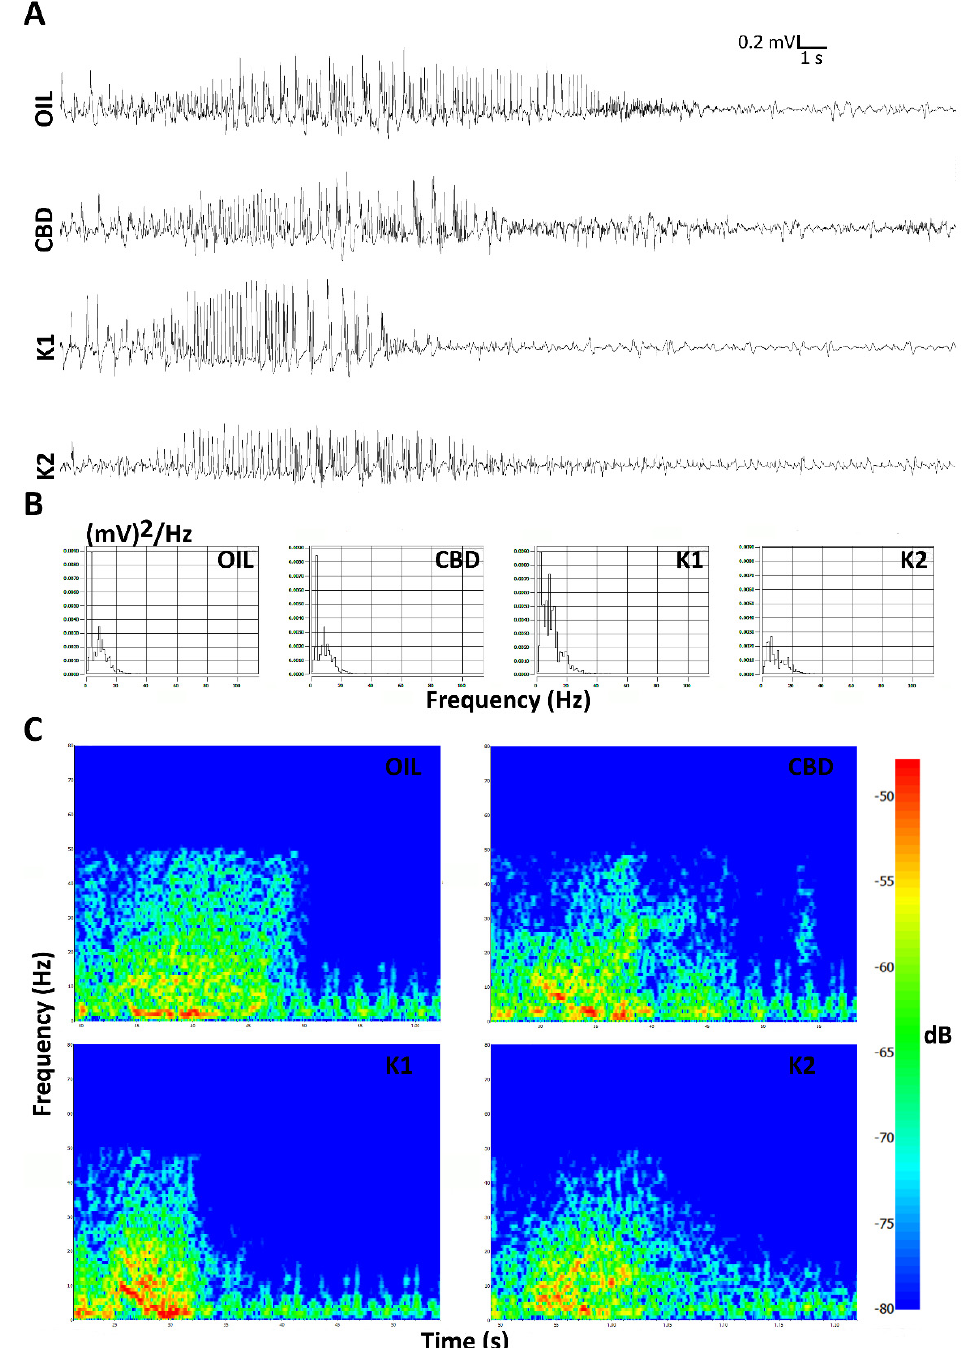
Figure 3. Seizures induced after the last session of 6-Hz corneal stimulation are illustrated. Seizures induced in K1- and K2-treated mice seemed to partially differ from those displayed by mice treated with either CBD alone or olive oil in the last session of the 6-Hz test. In ( A ), electrocorticographic (ECoG) traces are reported for all treatment groups. The power spectral density and power attenu- ation maps are represented, respectively, in ( B , C ). Scale: 0.2 mV/s. OIL, olive oil; CBD, cannabidiol; K1, hemp oil 1; K2, hemp oil 2.